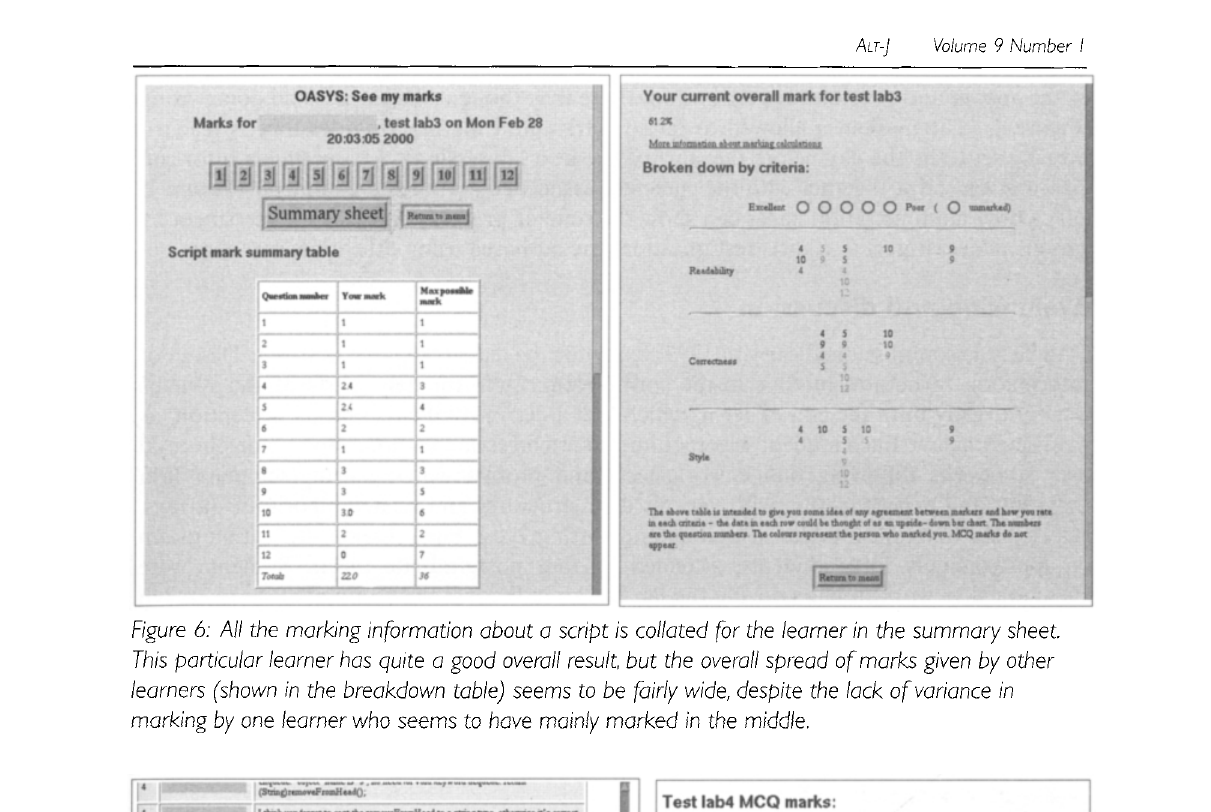
Figure 6: All the marking information about a script ~s collated for the learner in the summary sheet. This particular learner has quite a good overall result, but the overall spread of marks given by other learners (shown in the breakdown table) seems to be fairly wide, despite the lack of variance in marking by one learner who seems to have mainly marked in the middle.